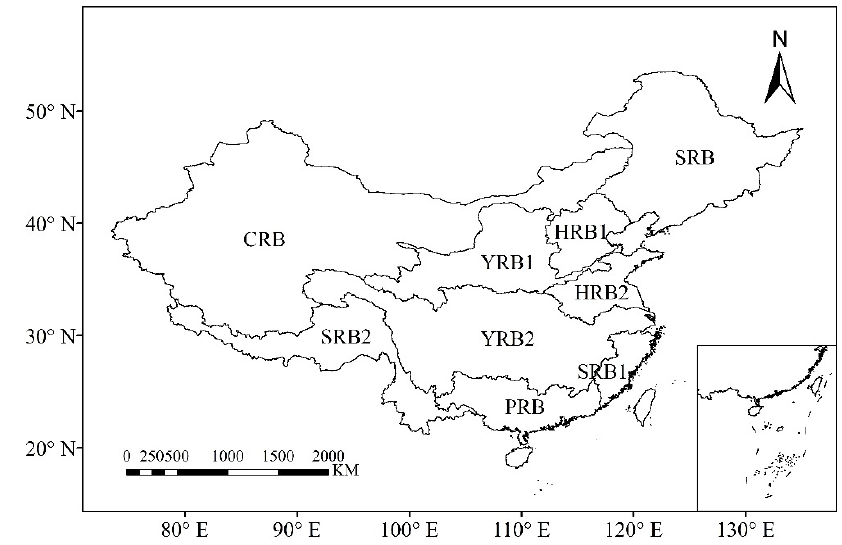
Figure 1. Study area. The study area was divided according to nine river basins in China; the Songliao River Basin (SRB), the Haihe River Basin (HRB1), the Huaihe River Basin (HRB2), the Yellow River Basin (YRB1), the Yangtze River Basin (YRB2), the Southeast River Basin (SRB1), the Southwest River Basin (SRB2), the Pearl River Basin (PRB), and the Continental River Basin (CRB), respectively.